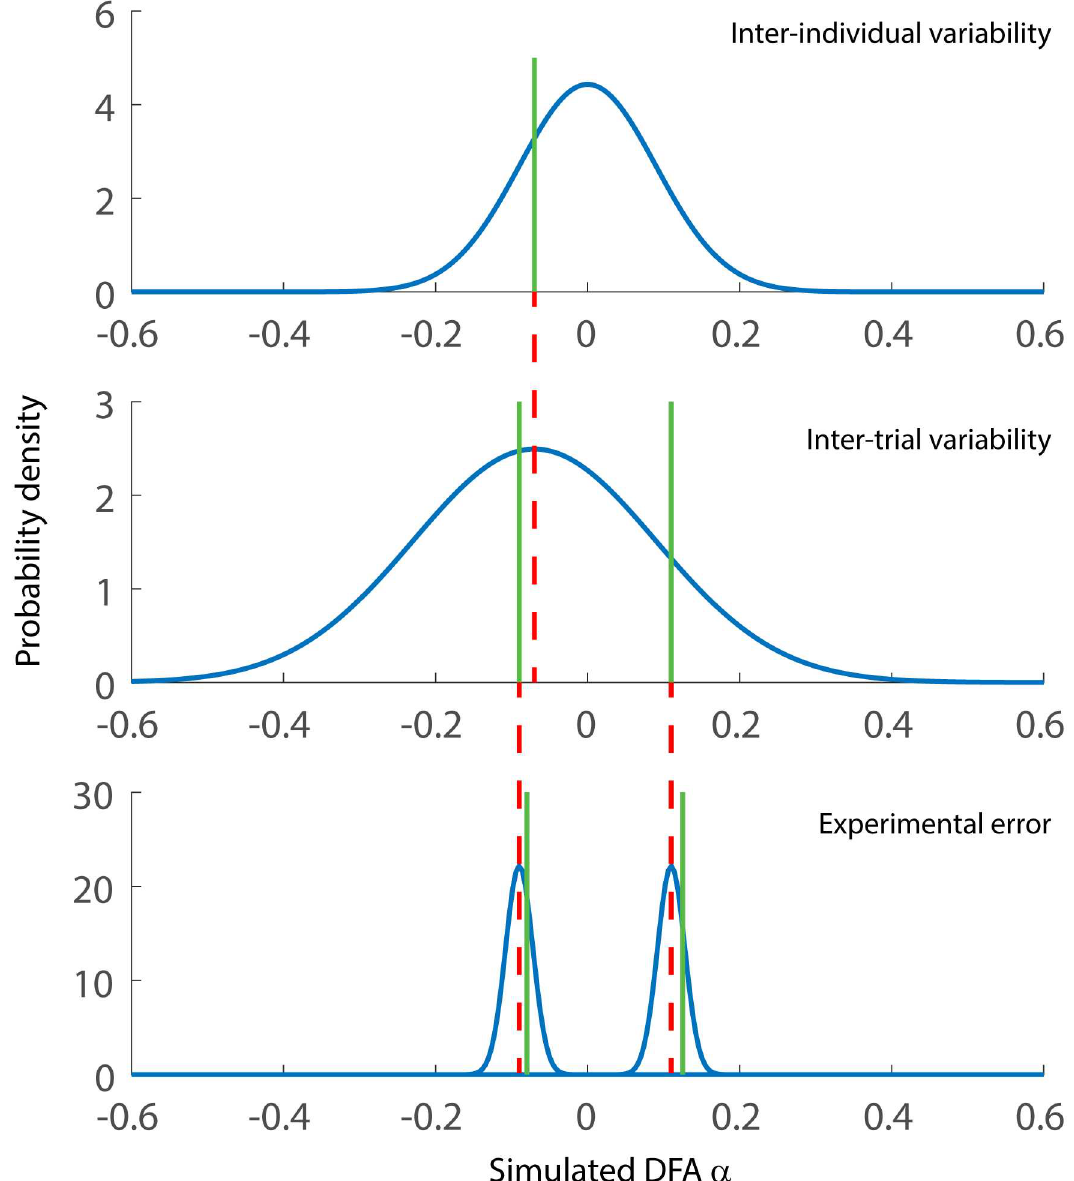
Fig 1. Illustration of the process for generating a simulated DFA α value for a single subject. A randomnumber (green line) is drawn from a normal distribution with mean 0 and SD = 0.09 which represents expectedinter-individual variability. Then two randomnumbers are drawn from the distribution centered on the individualdeviationvalue (red dotted line) and SD = 0.16. This distribution simulates the expectedvariability of DFA α from trial to trial when using time series consisting of 100 data points (the SD of this distributionis smaller for longertime series). In this case, two trials are illustrated but we used 1, 2, 4, 6, and 8 trials in the full simulation. The experimental error is added to the trial values. in the final step of the simulation. The overall group value, μ , is then added to the averageof the two resultingvalues to obtain the simulatedDFA α value for a single individual.In the between-subjects version of the Monte Carlo simulations, two groups are simulatedby drawingrandomly from two independentnormal distributions. In the within-subjects version, random numbers were drawn from a bivariatenormal distribution ensuringcorrelationof 0.89 (see Method section).